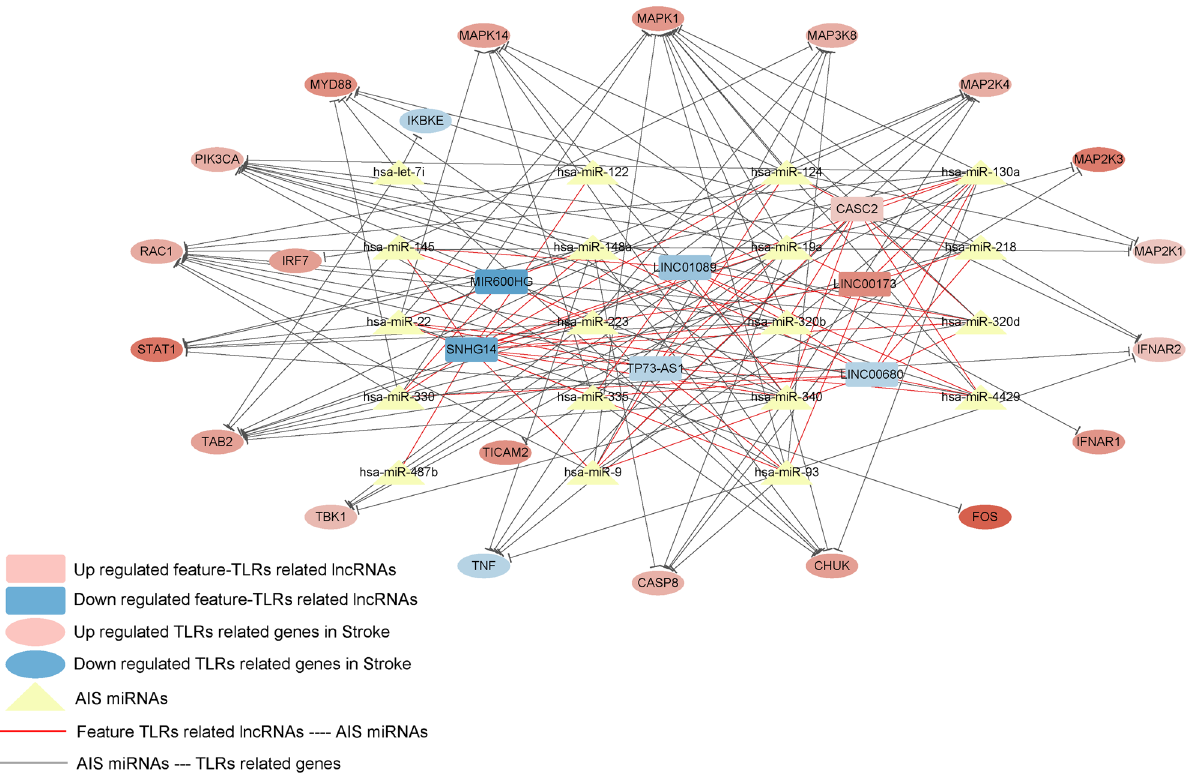
Figure 5. The ceRNA network consisting of the immune and TLR signaling pathway related feature lncRNAs and AIS related miRNAs and TLR signaling pathway related